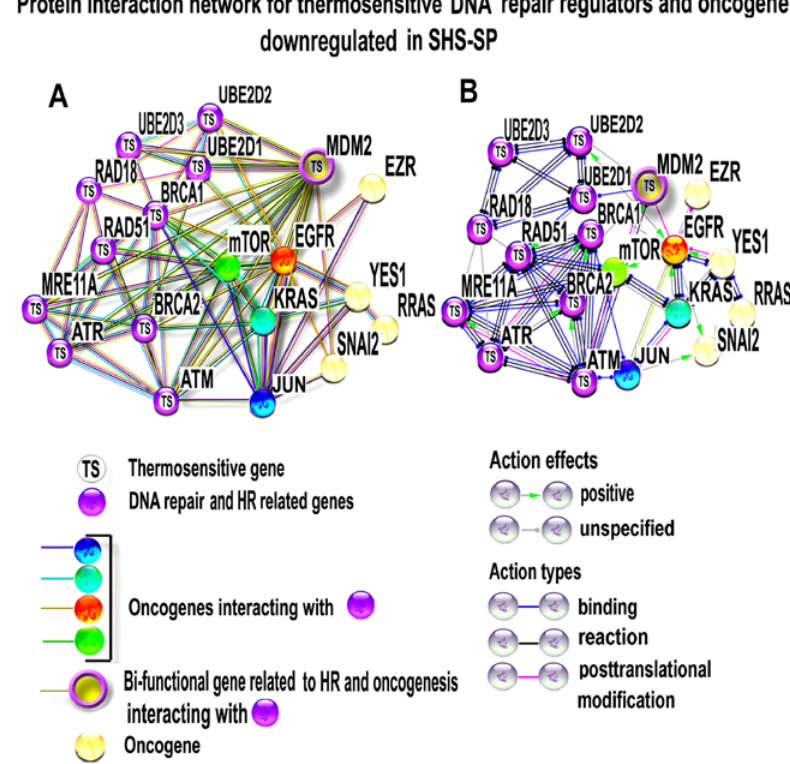
Figure 8. Protein interaction network for thermosensitive HR regulators and oncogenes that decreased expression in sublethal heat shock survived progeny (SHS-SP). The network constructed with ATM, ATR and BRCA1 interacting genes (presented also at Figure 2B). ( A ) evidence view illustrating multiple bonds between thermosensitive HR regulators and oncogenes. ( B ) molecular action view indicating that HR regulators and oncogenes are interconnected only with positive or unspecified interactions. The networks in ( A , B ) were constructed using STRING server at interaction confidence above 0.9. This figure illustrates a tight interaction between thermosensitive HR regulators and oncogenes confirming that SHS related HR inhibition also switches off severe oncogenes.